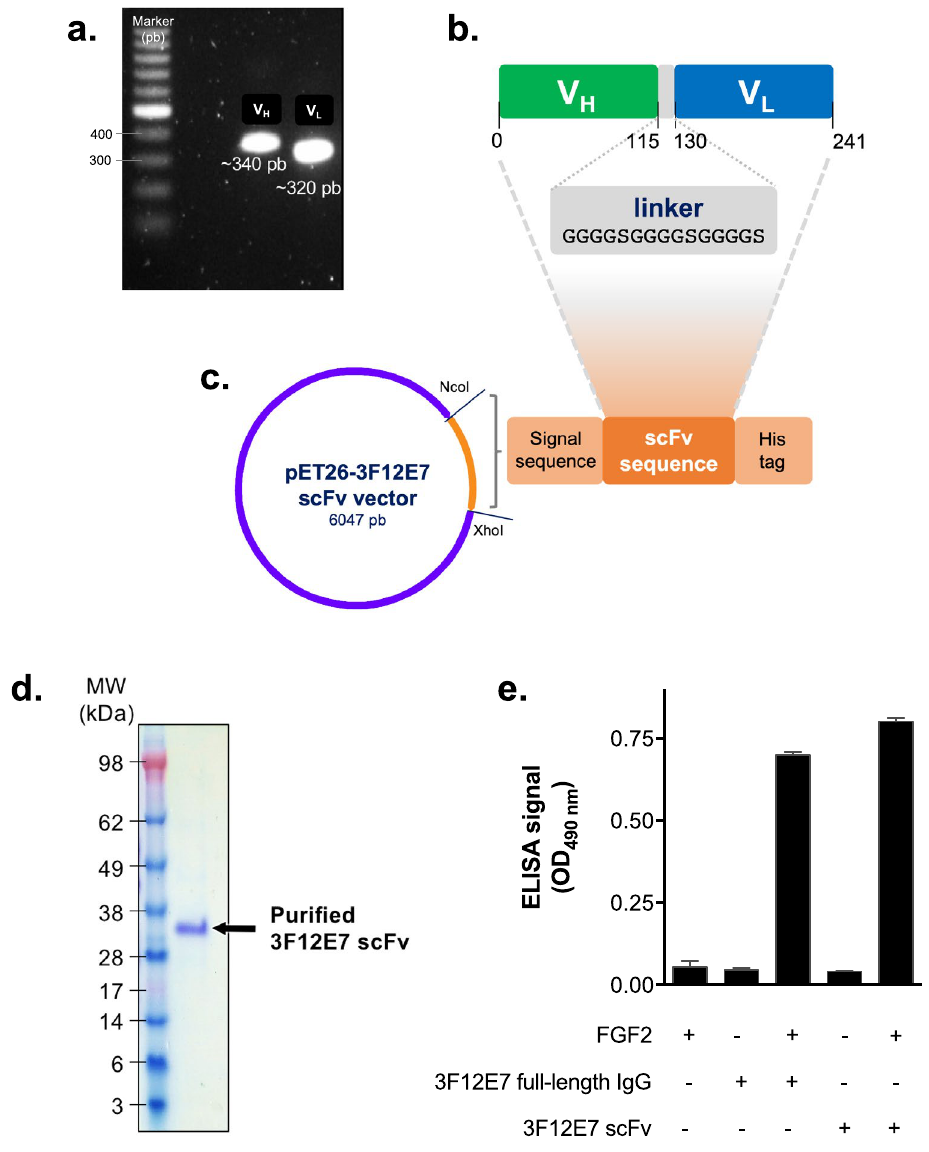
Figure 1. Generation of 3F12E7 anti-FGF2 scFv. ( a ) Agarose gel electrophoresis of PCR amplified products of V L and V H genes from 3F12E7 hybridoma cells. ( b ) Design of the 3F12E7 scFv construct, formed by V H and V L amino acid sequences attached by a flexible peptide linker [(G 4 S) 3 ]. ( c ) Schematic representation of the pET26-based vector used for the expression of 3F12E7 scFv in E. coli . The insert codes the scFv linked to a signal sequence and a C-terminal 6 × His tag. ( d ) SDS-PAGE analysis of the affinity-purified 3F12E7 scFv, under denaturing and reducing conditions. Gel protein content was detected by Coomassie blue staining. ( e ) Binding of 3F12E7 scFv to FGF2 was accessed by ELISA. 3F12E7 full-length IgG was used as a positive